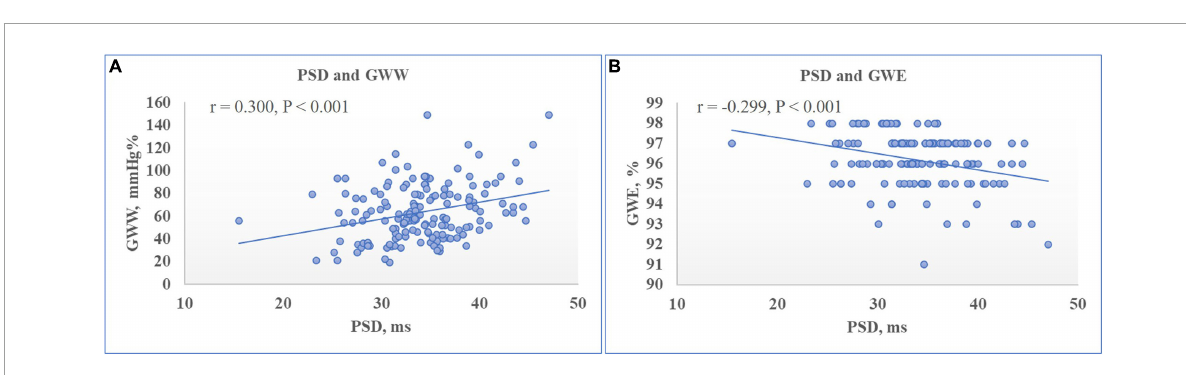
FIGURE4 Relationship between left ventricular (LV) myocardial work indices and LV peak strain dispersion (PSD). Scatter plot showed that PSD was positively correlated to LV global wasted work (GWW) (A) while negatively correlated to global work efficiency (GWE) (B)